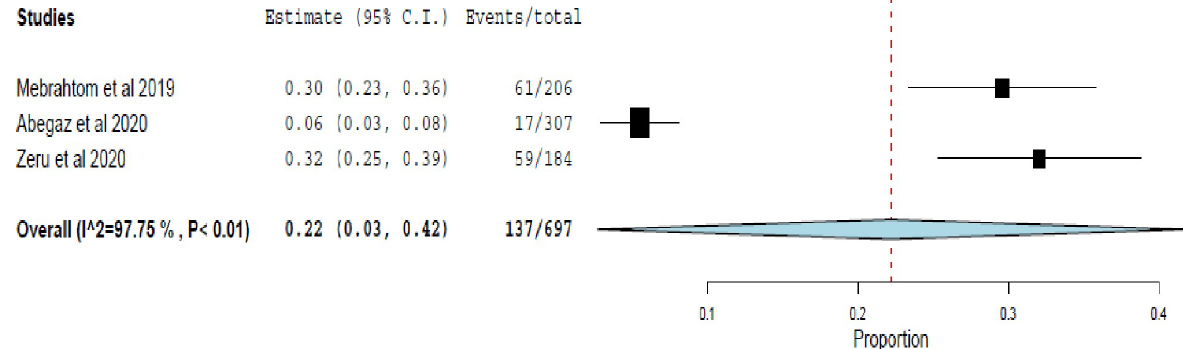
Fig 6. The rate of well-controlled asthma assessed using the Asthma Control Test (ACT).